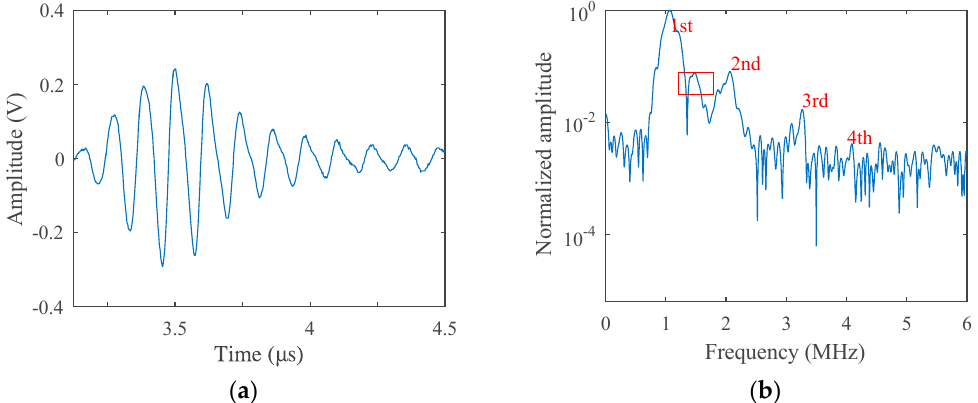
Figure 8. ( a ) Transmitted signals received from the fatigue sample (Loading Cycle 5000) in the time- domain and ( b ) in the frequency-domain (excitation voltage 200 V).